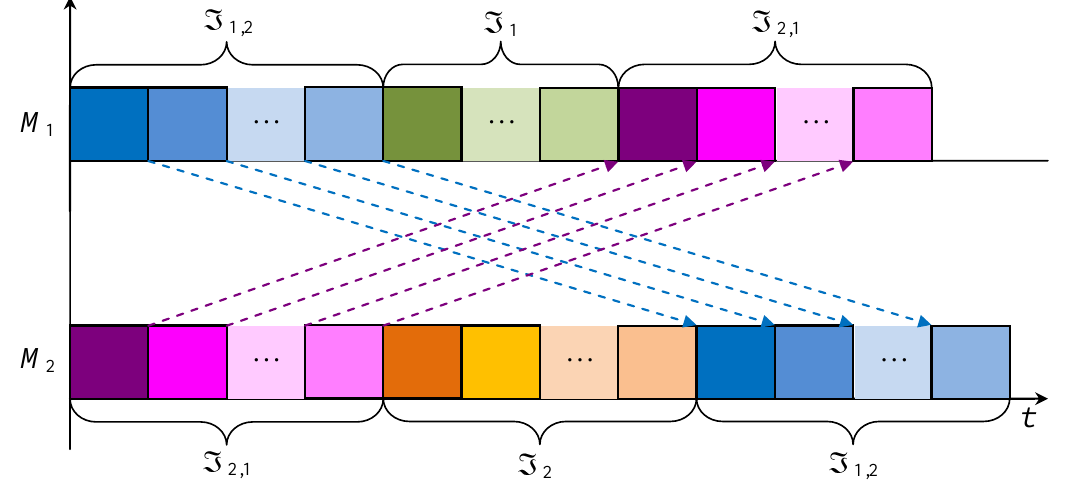
Figure 1. An example of the optimal semi-active schedule without idle times on both